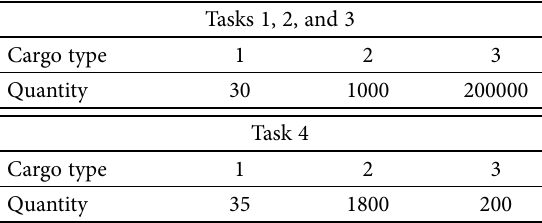
Table 2. Cargo quantities to be transported Tasks 1, 2, and 3